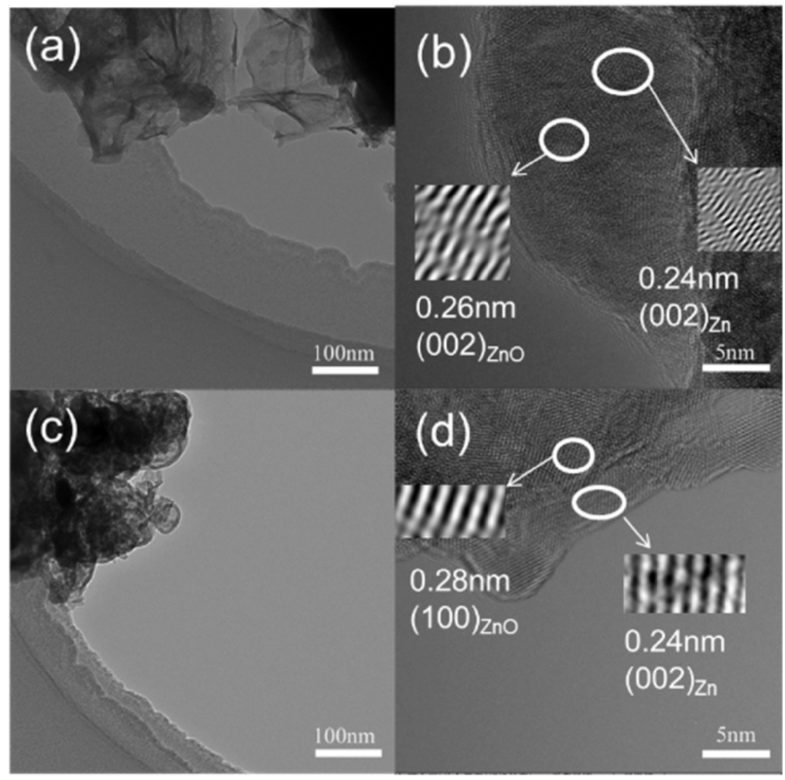
Figure 5. Transmission electron microscopy (TEM) images of ( a , b ) Zn-N 2 electrode and ( c , d ) Zn-CO 2